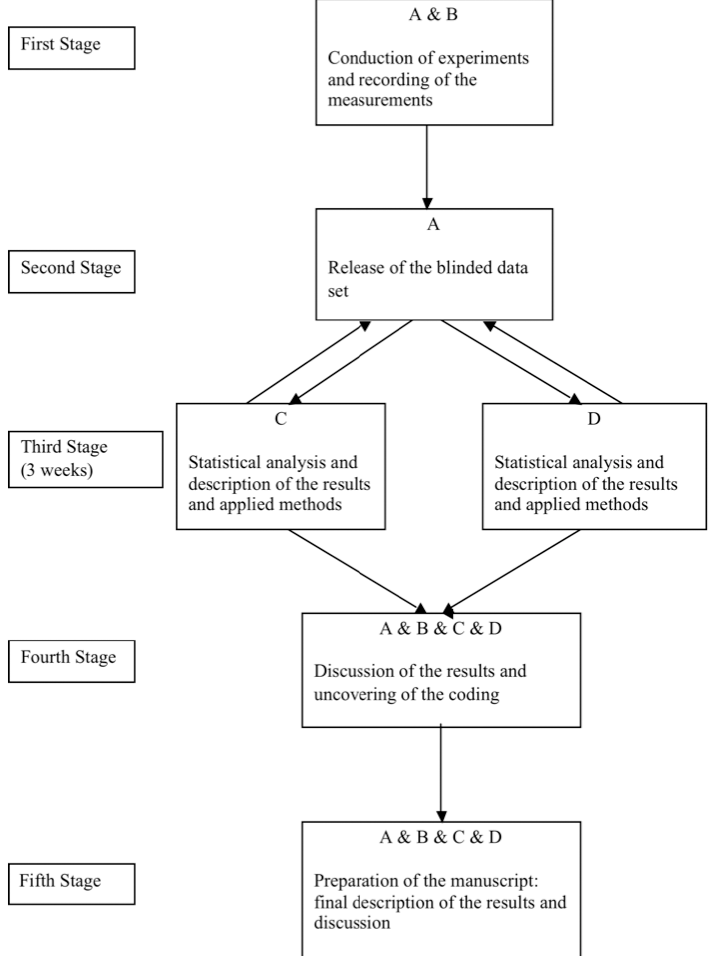
Figure 1. Plan of the independent blinded statistical analysis.